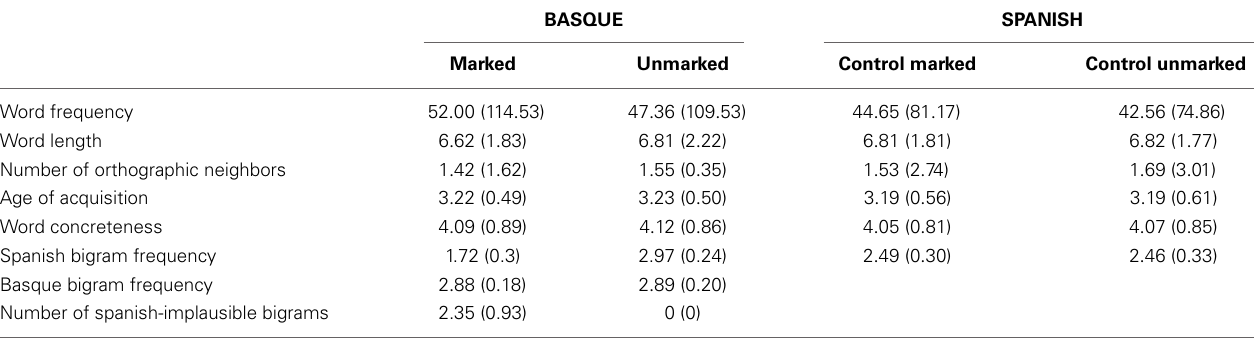
Standard deviations are provided within parentheses. Table 3 | Mean latencies (in milliseconds) and error rates (in percentage) for words in the four conditions and participant groups for speeded language decision task (Experiment